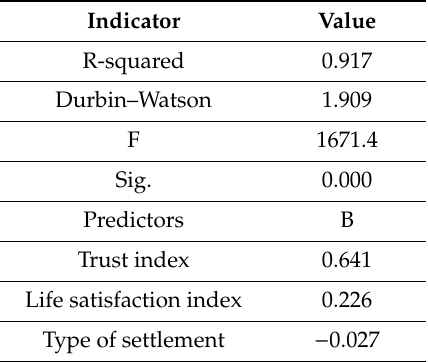
Table A5. Regression model D. Dependent variable: security